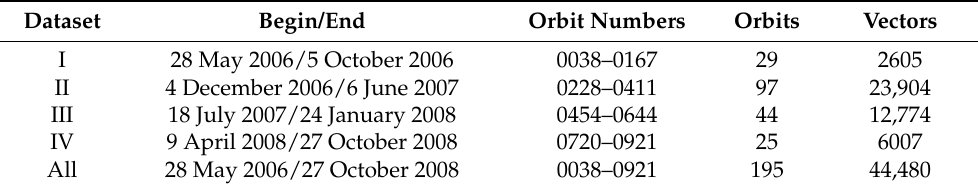
Table 1. Number of retrieved vectors from Visible and InfraRed Thermal Imaging Spectrometer (VIRTIS-M) data depending on observation periods. Data are artificially grouped into four datasets, with approximately 2-month long intervals between